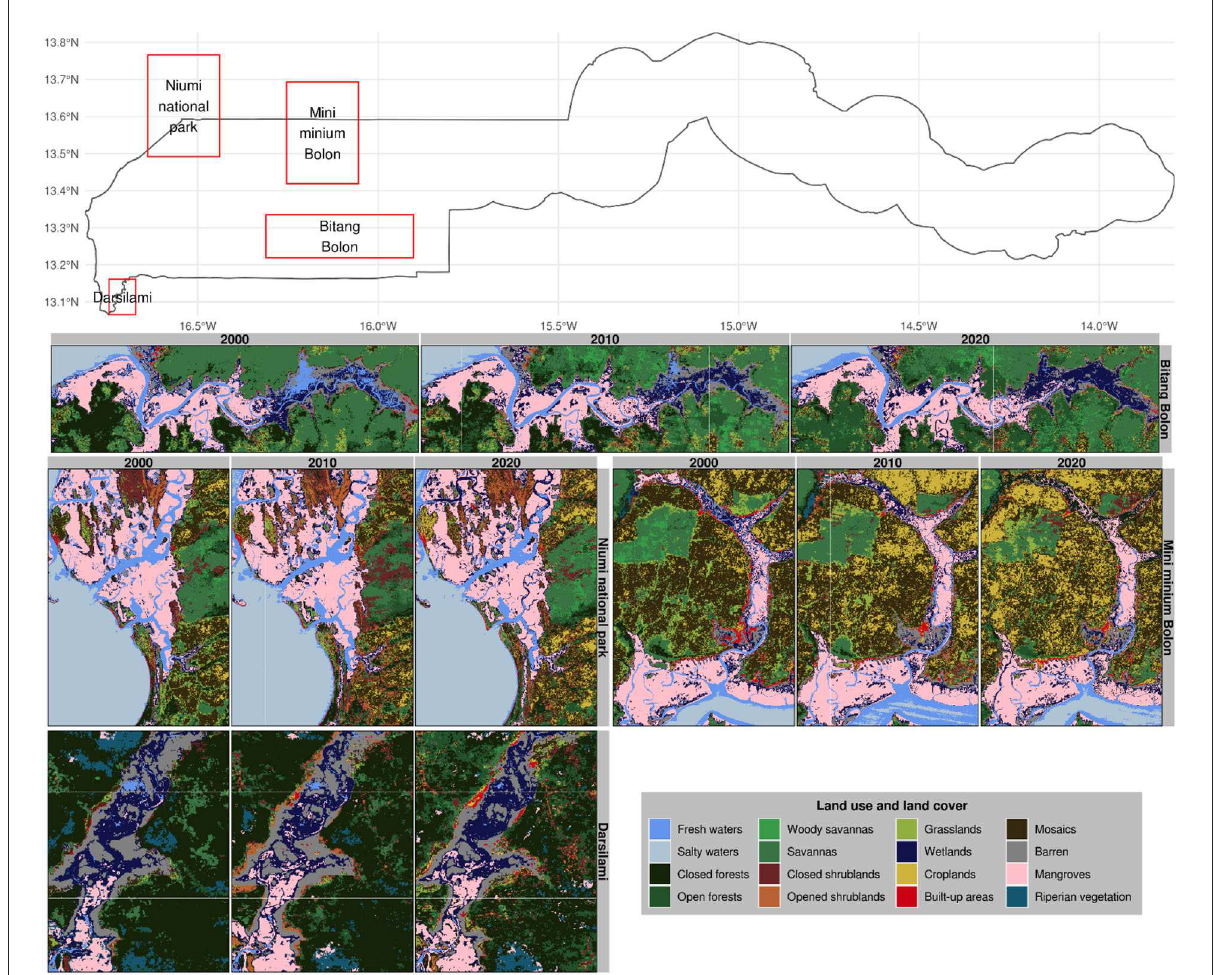
FIGURE9 Land use and land cover classifications in selected mangrove sites of The Gambia based on harmonic modeling and classification of Landsat and MODIS time series. These maps are snapshots of Bitang Bolon, Mini Minium Bolon, Niumi national park, and Darsilami.